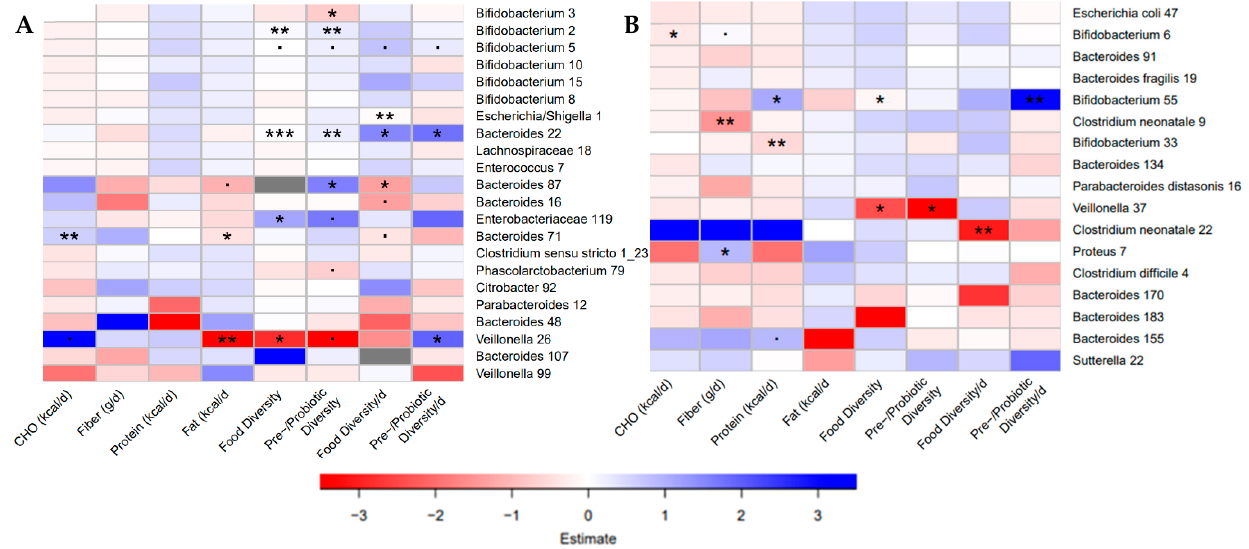
Figure 4. Bacterial taxa in both communities were associated with dietary variables. ( A ) Heatmaps of the associations found in negative binomial regressions when adjusted for total caloric intake (kcal/d) and age at introduction (weeks) in the Baby, Food & Mi study. ( B ) Heatmaps of the associations found in negative binomial regressions when adjusted for total caloric intake (kcal/d) and age at introduction (weeks) in the LucKi-Gut study. Negative associations are shown in red, while positive associations are shown in blue. ( p < 0.1, * p < 0.05, ** p < 0.01, *** p < 0.001).